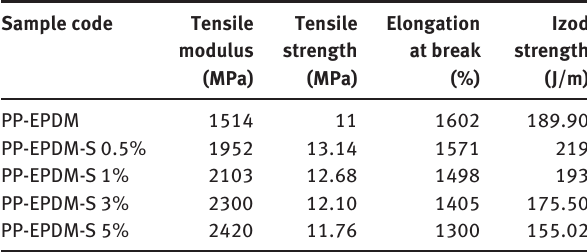
Table 4 Mechanical properties of the PP/EPDM/SWNT